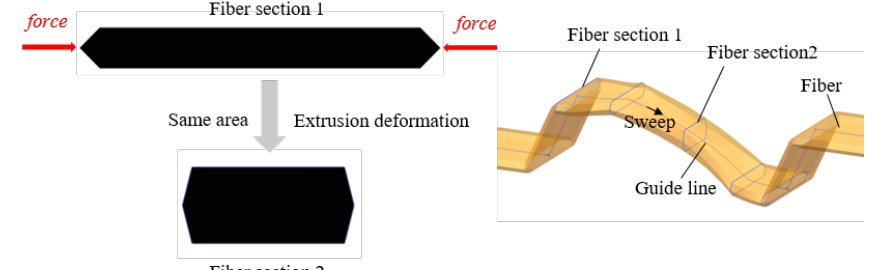
Figure 4. Schematic diagram of fiber deformation and modeling.